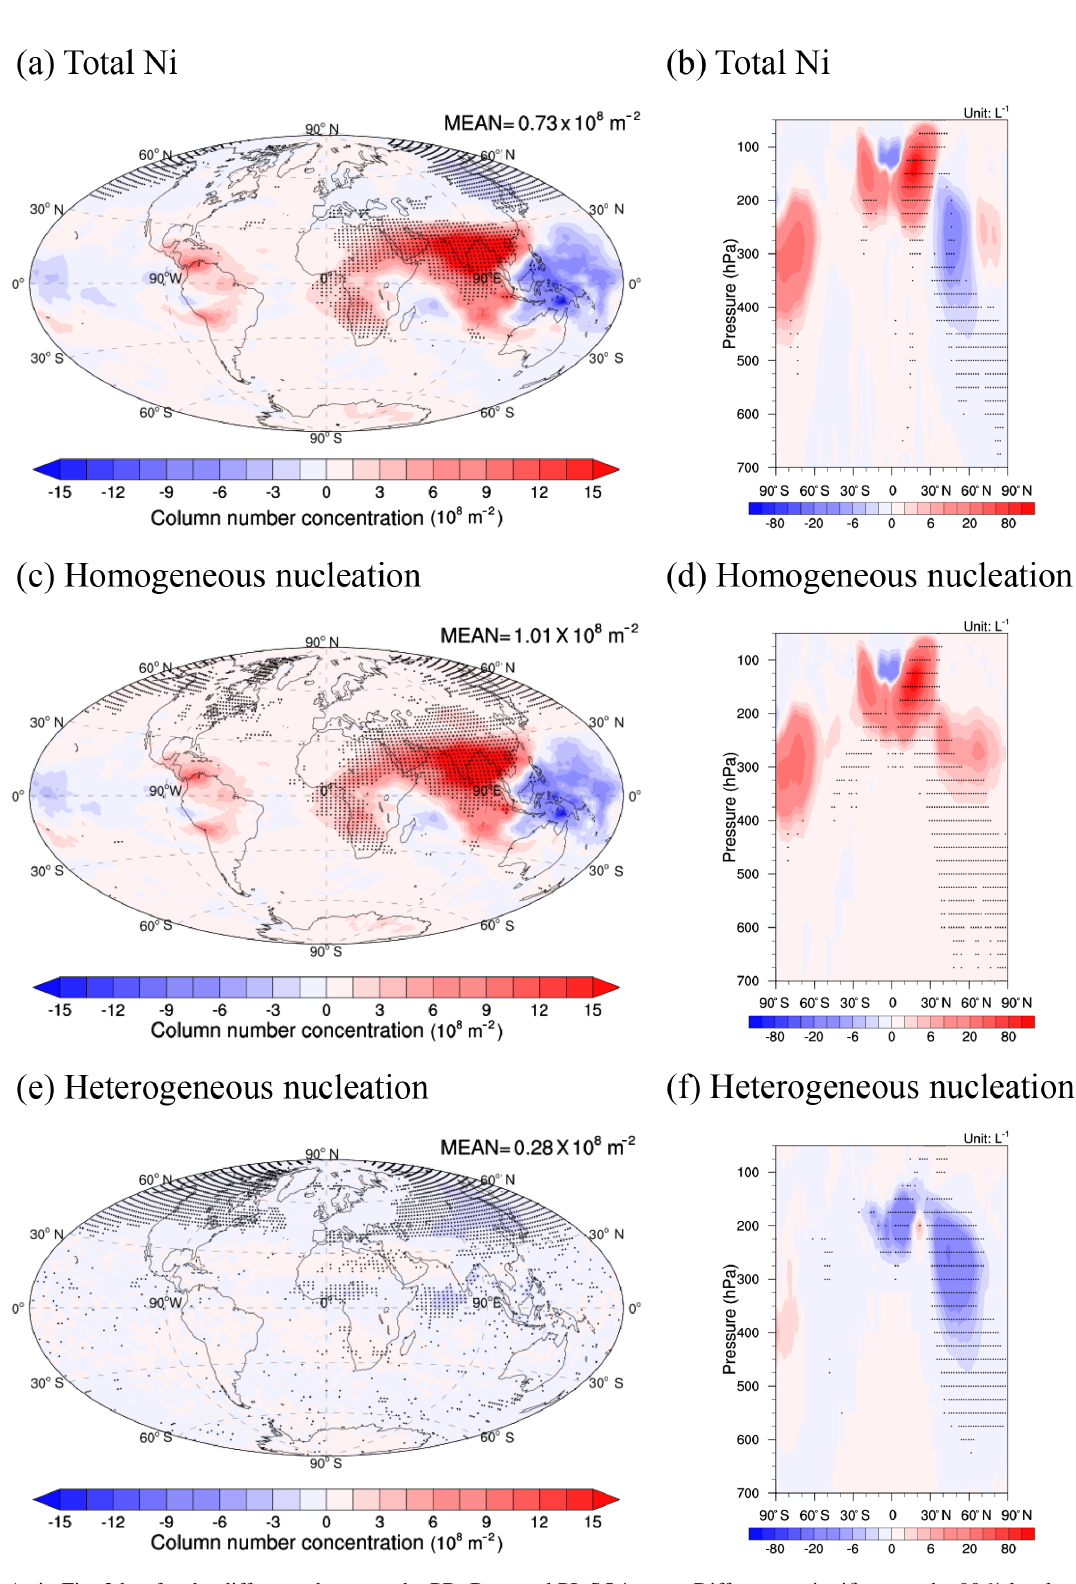
Figure 4. As in Fig. 3 but for the difference between the PD_Base and PI_SO4 cases. Differences significant at the 90% level according to a Student’s t test are depicted by